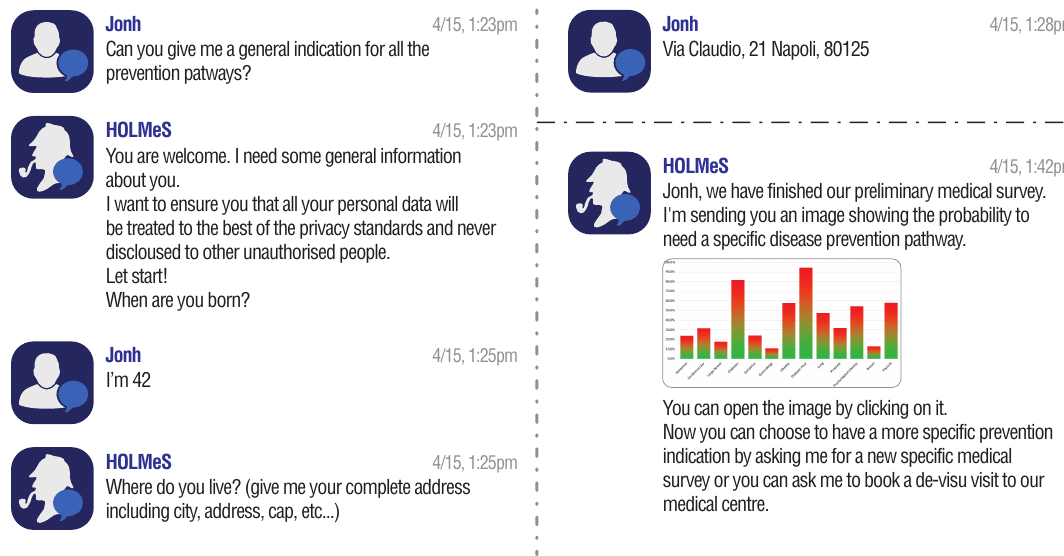
Figure 6. Conversing with HOLMeS via the chat-bot interface: Asking for general indications about the available prevention pathways.